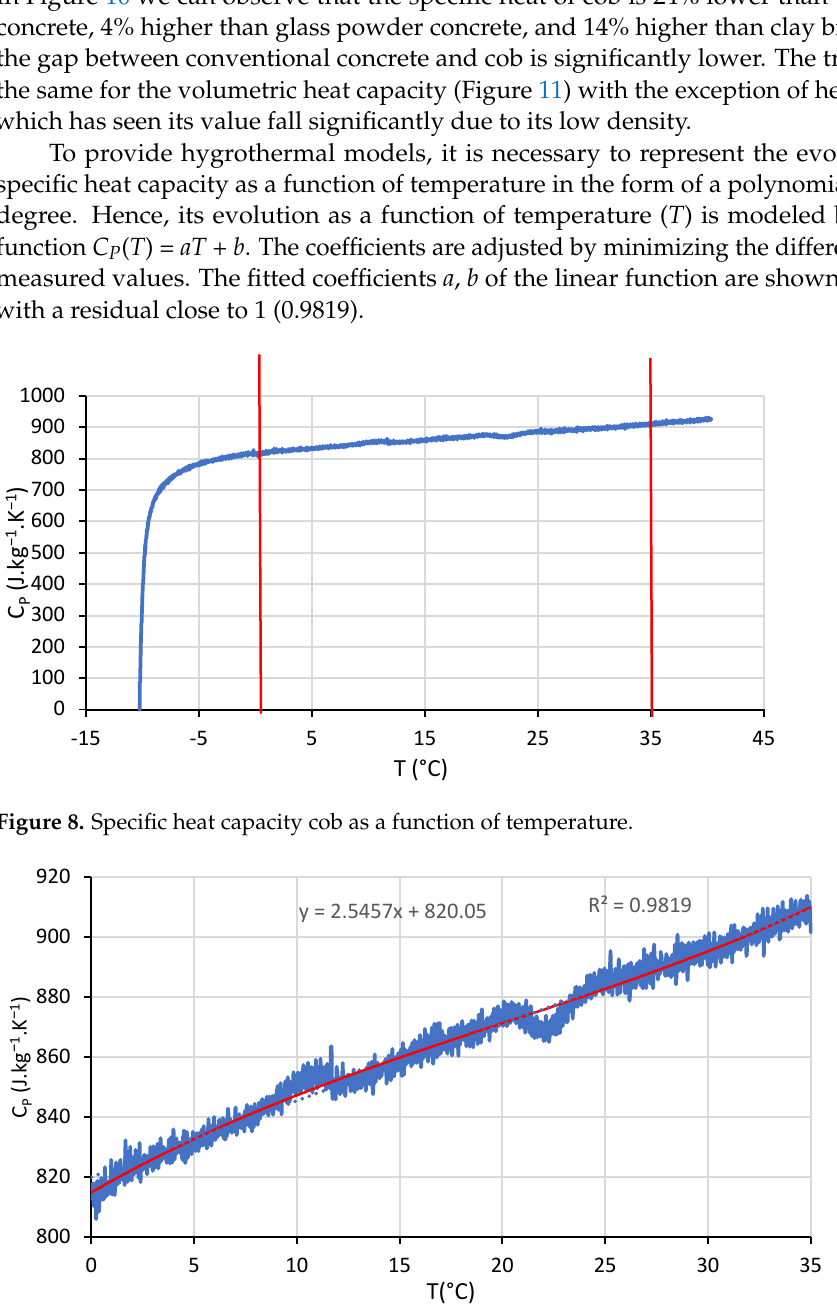
Figure 10. Comparison of cob’s specific heat with different materials.